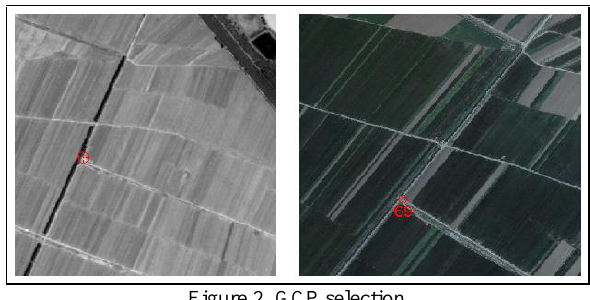
Automatic selection of tie points are through image matching in Figure 3. A total of 54 tie points are selected.